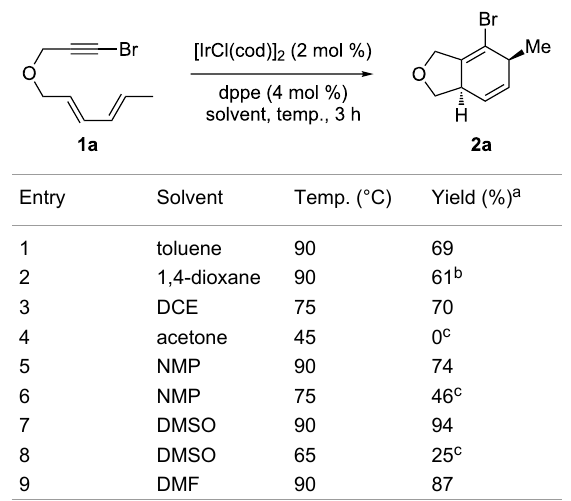
Table 2: Optimization of solvent and temperature for the [IrCl(cod)] 2 / dppe-catalyzed [4 + 2] cycloaddition of 1a